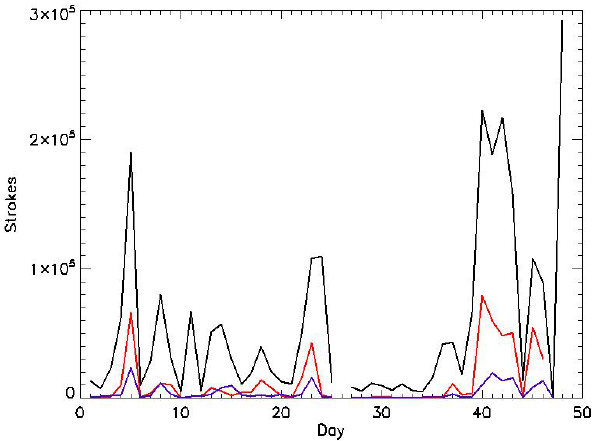
Figure 2. LINET stroke count time series for the 1 Jan­12 Feb 2006, corresponding to the active monsoon in northern Australia. Total strokes (black line), in­cloud strokes (red line) and cloud­ground strokes (blue line) are depicted. The rise in the count on 21 st January corresponds to the onset of the mesoscale convective system. The gap in the data between 25­26 January corresponds to an inactive period of LINET.